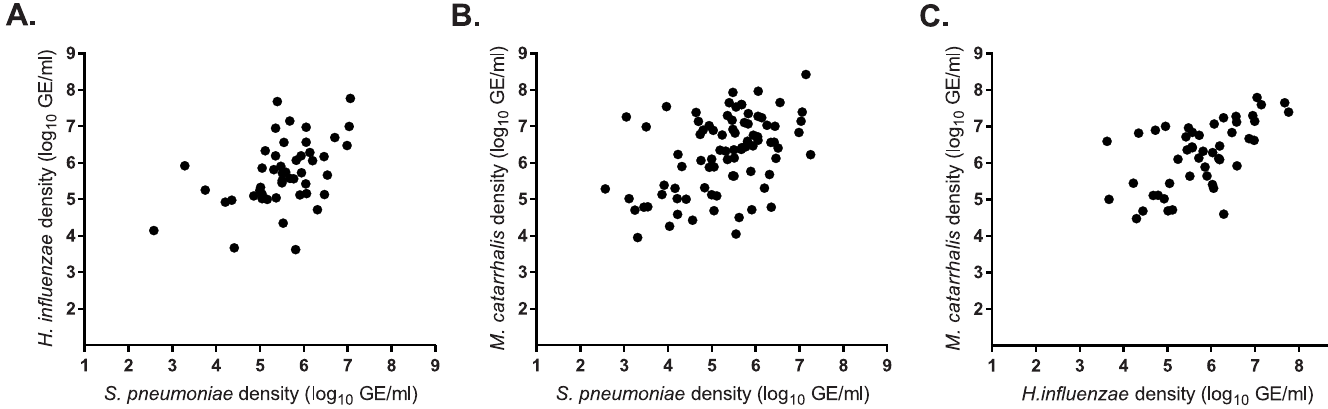
Fig 3. Density of S . pneumoniae and H . influenzae (A), S . pneumoniae and M . catarrhalis (B), and M . catarrhalis and H . influenzae (C) when present as co- colonizing species. Density are reported in log 10 genome